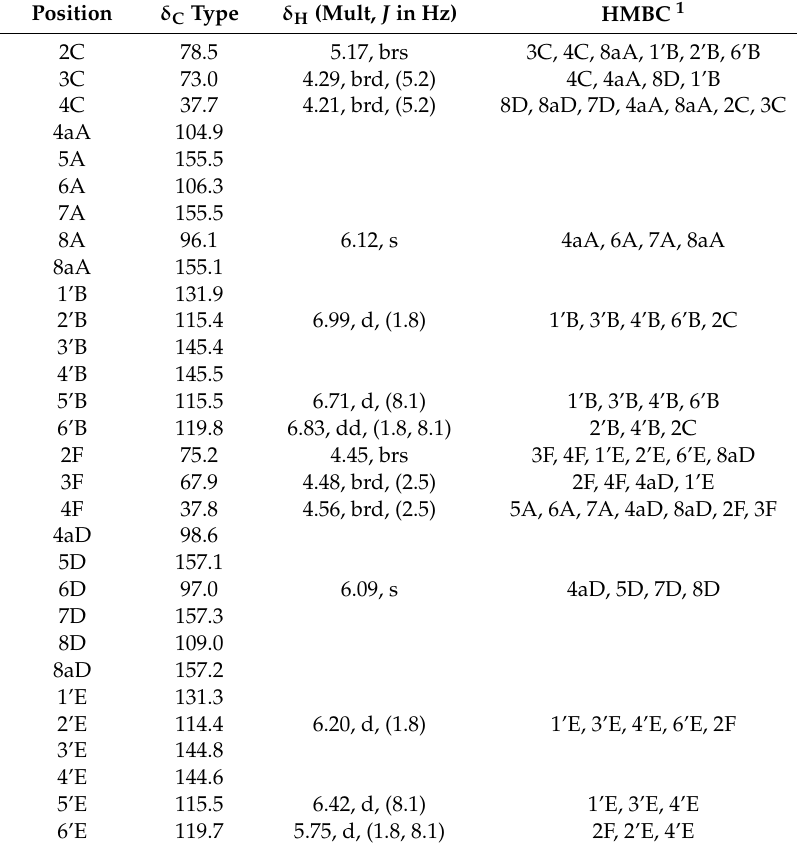
Table 2. 1 H- and 13 C-NMR assignments and HMBC